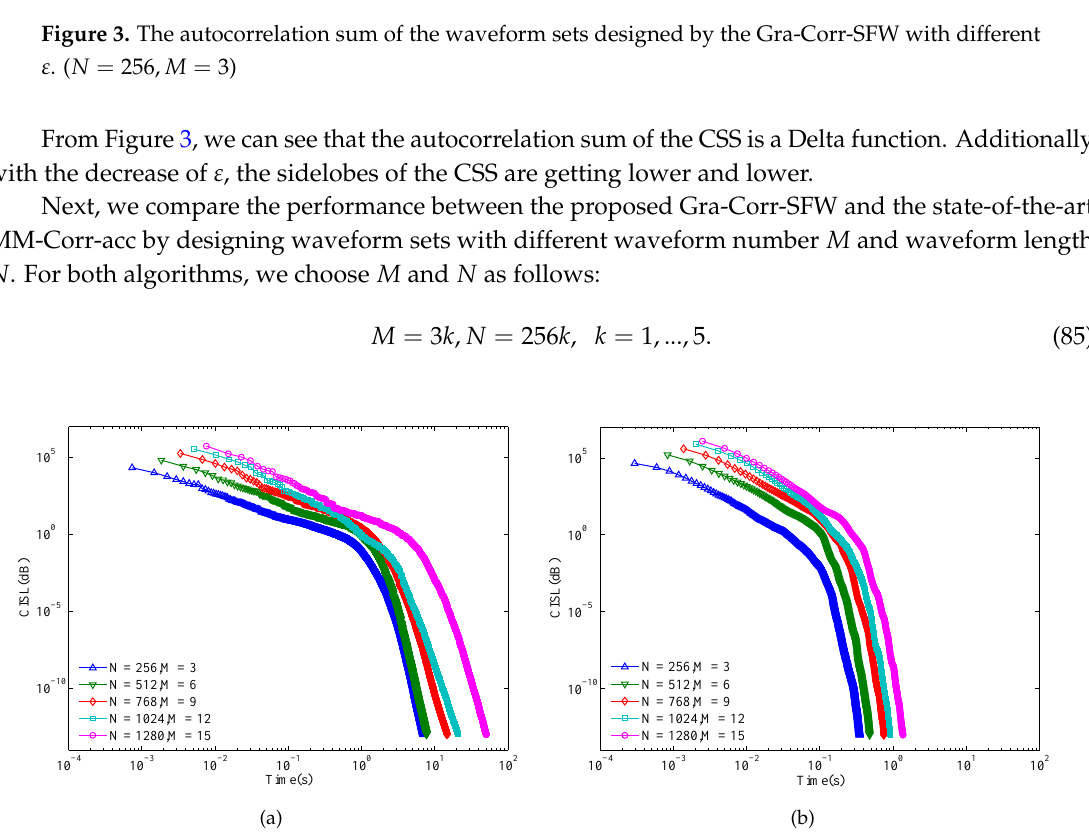
Figure 4. Evolution of the CISL with respect to the running time: ( a ) MM-Corr-acc; ( b ) Gra-Corr-SFW. ( ε = 10 − 13 )